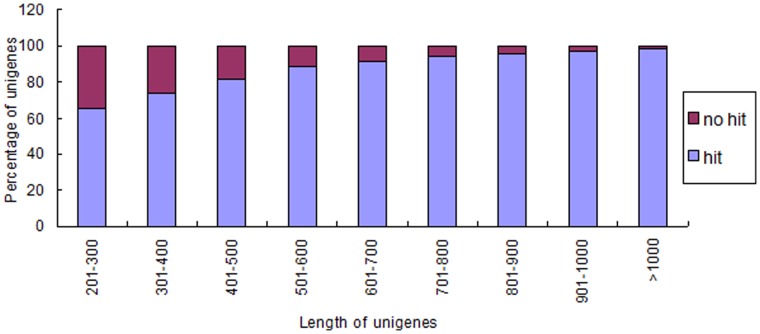
Comparison of unigene length between hit and no hit unigenes.Longer contigs were more likely to have BLASTx homologs in protein database.